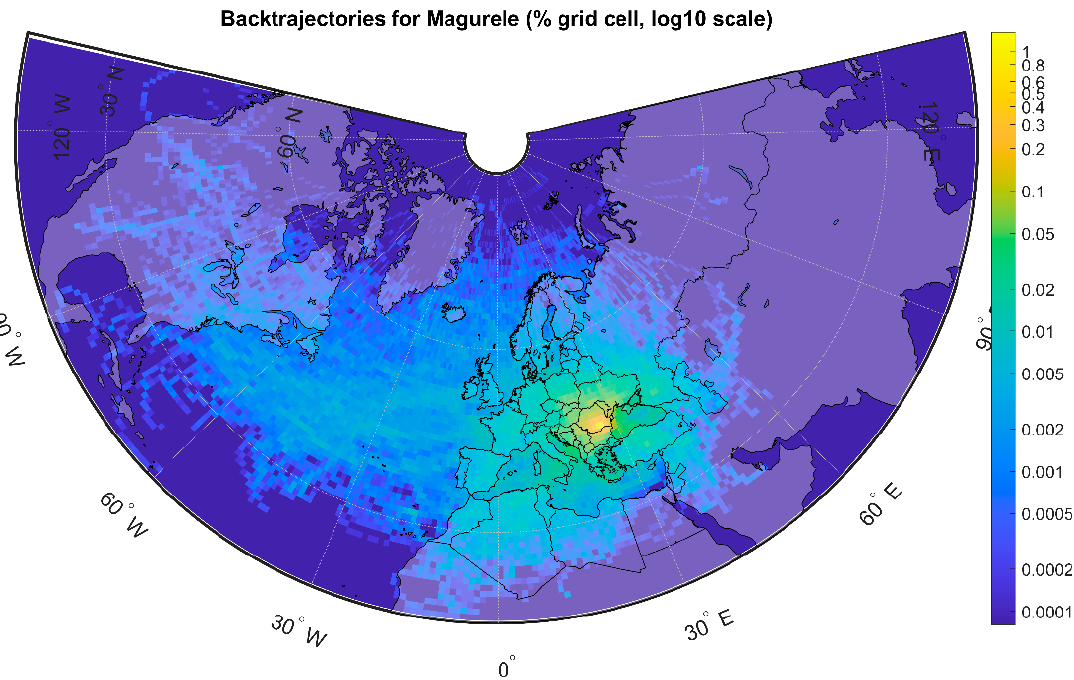
Figure A1. HYSPLIT back-trajectories for 5167 events. The % grid cell represents the number of observations in a grid cell to the total number of observations.